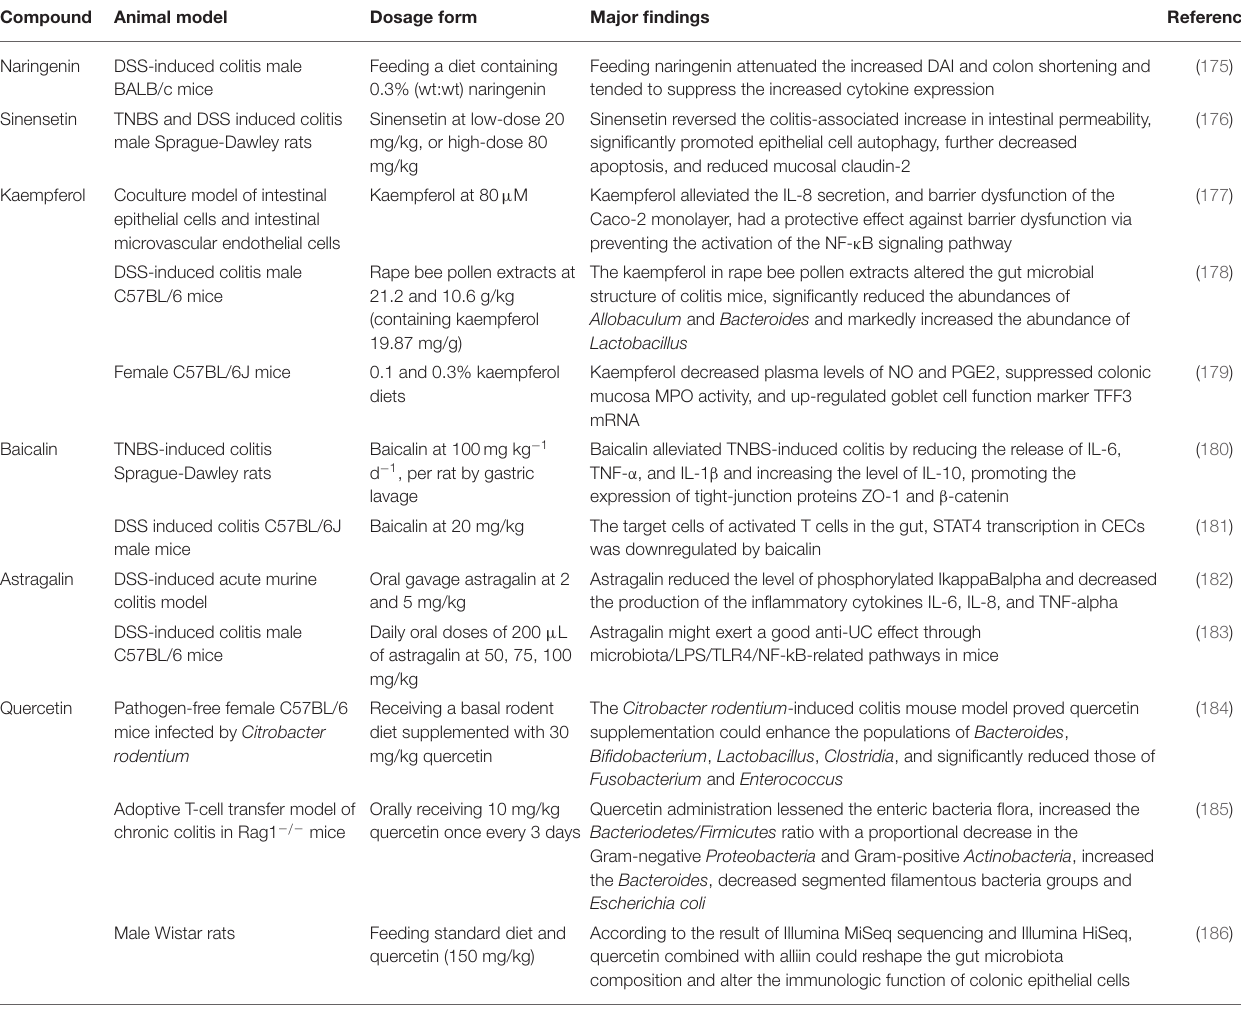
TABLE 4 | The affection of flavonoids on gut microbiota and